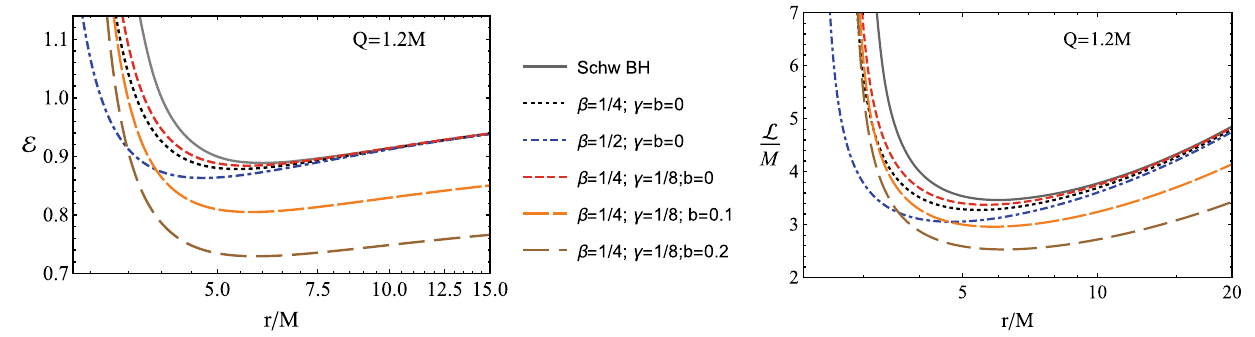
Fig. 7 Radialprofilesofspecificenergy(leftpanel)andangularmomentum(rightpanel)correspondtocircularorbitsoftestneutralandmagnetized particles around EMS BHs for the different values of parameters β,γ and β . In both plots, we chose the BH charge as Q / M = 1 . 2 Fig. 8 ISCO radius of magnetized particles around EMS BHs as a function of electric charge of the BH for different values of parameters β,γ and